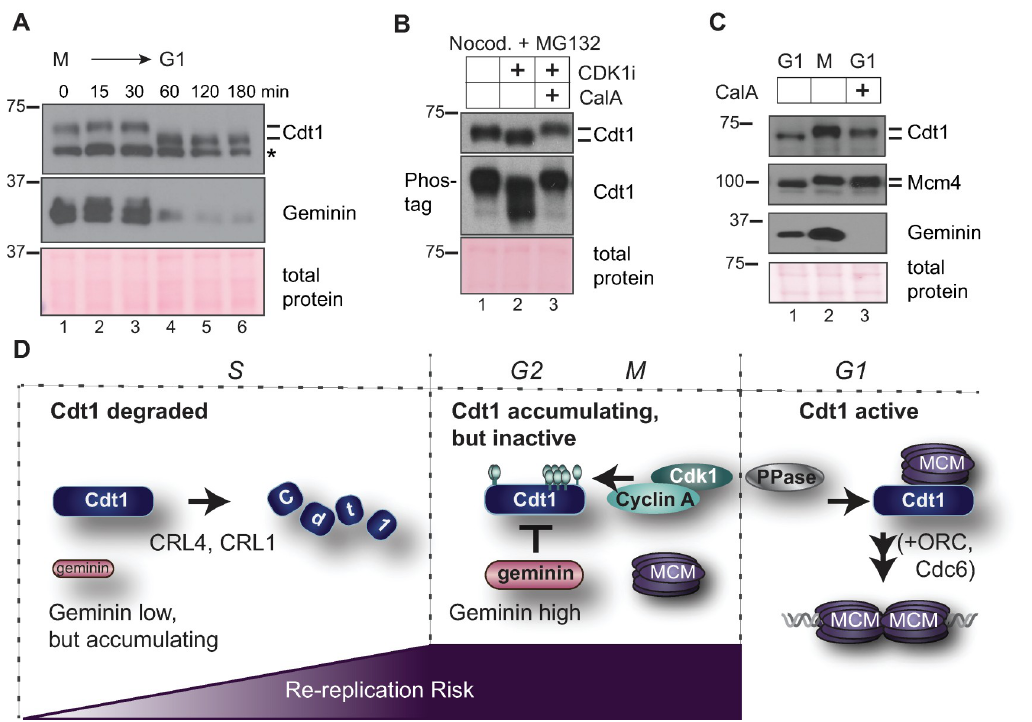
Fig 6. Cdt1 dephosphorylation at the M-G1 transition requires PP1. A ) Nocodazole-arrested U2OS cells were released into fresh medium and collected at the indicated time points. Endogenous Cdt1 phosphorylation (top) and Geminin (middle) degradation were analyzed by immunoblotting; Ponceau S staining for total protein and a non-specific band ( � ) serve as loading controls. The results are representative of two independent experiments. B ) Nocodazole-arrested U2OS cells were mock treated (lane 1) or treated with 10 μ M RO-3306 to induced dephosphorylation (CDK1i, lane 2), or treated with both 10 μ M RO-3306 and with 20 nM calyculin A as indicated (CalA, lane 3). Endogenous Cdt1 phosphorylation was analyzed by standard or Phos-tag SDS-PAGE followed by immunoblotting; total protein stain serves as a loading control. The results are representative of three independent experiments. C ) Nocodazole-arrested U2OS cells (lane 2) were released into fresh medium for 3 hours and mock treated (lane 1) or treated with 20 nM calyculin A 30 minutes after release (lane 3). Endogenous Cdt1 or MCM4 phosphorylation and total Geminin were detected by immunoblotting; total protein stain serves as a loading control. The results are representative of three independent experiments. D ) Model. In S phase Cdt1 is targeted for degradation, first by the CRL4 Cdt2 E3 ubiquitin ligase at the onset of S phase and then additionally by SCF Skp2 after phosphorylation by Cyclin A/CDK2. Geminin accumulates starting in early S phase. The amount of duplicated DNA at risk of re-replication is lowest in early S and highest in G2. In late S and G2 phase Cdt1 re-accumulates and Geminin is at high levels. Cyclin A/CDK1 phosphorylates Cdt1, and both Geminin and Cdt1 hyperphosphorylation independently block Cdt1-MCM binding. At the M ➔ G1 transition a calyculin A-sensitive phosphatase, possibly PP1, is required for Cdt1 dephosphorylation to reactivate MCM loading by Cdt1, ORC, and Cdc6.